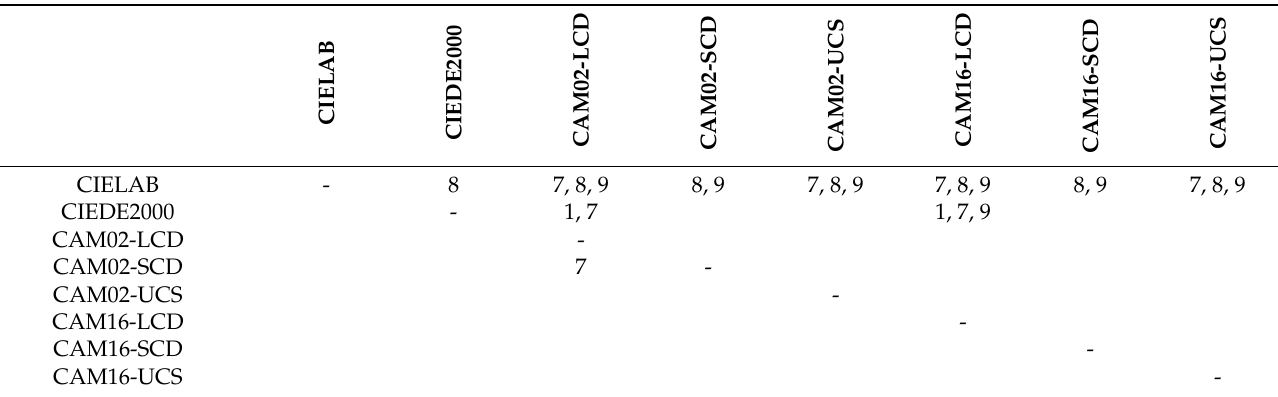
Table 4. F-test results [25] from values in Table 3 showing the numbers of the phases (Table 1) with statistically significant improvements of the color-difference formula in the first row with respect to that in the first